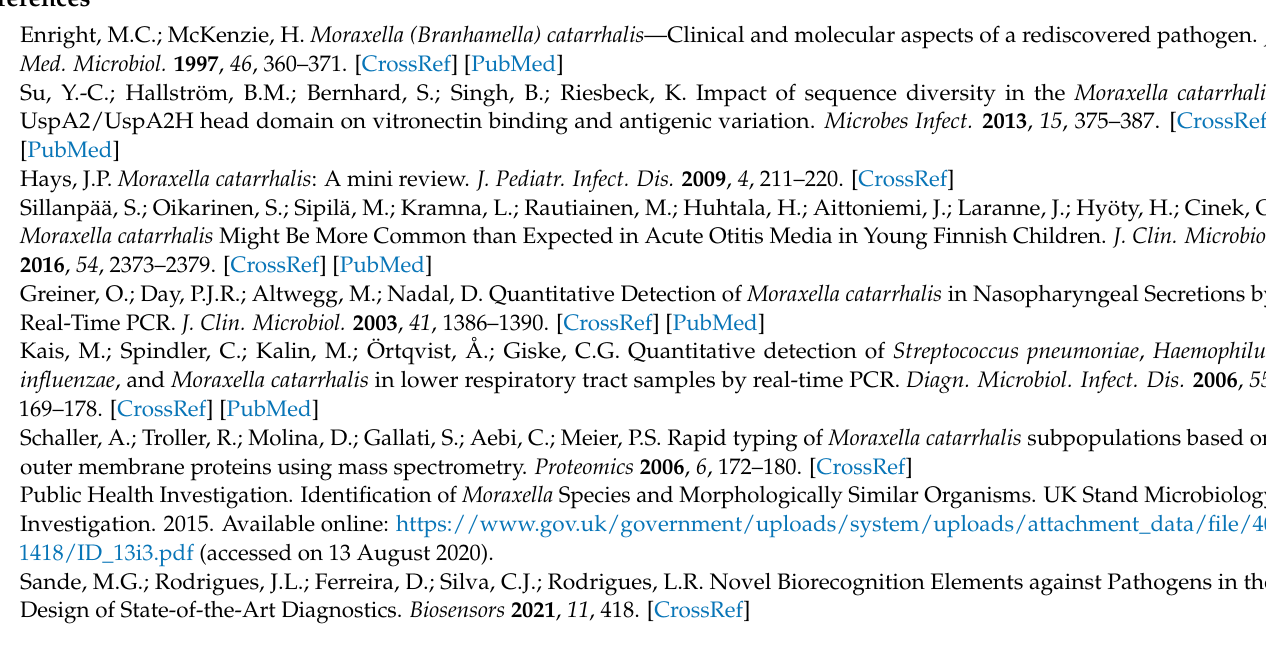
Figure S3: PCR amplification gels after each of the eight cell-SELEX cycles; Figure S4: Au electrode; Figure S5: Representation of the Randles’ equivalent circuit; Figure S6: SDS–PAGE gel of E. coli UspA2 protein lysates; Figure S7: Determination of the equilibrium dissociation constant ( K d ) of the candidate aptamers; Figure S8: Bode phase plot of the biosensor assembly. Table S1: Primers for PCR amplification of the UspA2 gene and the pASK_IBA2 plasmid; Table S2: Oligonucleotide sequences used in the aptamer selection, validation process and immobilization on the biosensor; Table S3: Predicted secondary structures of the other nine highest-copy aptamers and their reverse complement